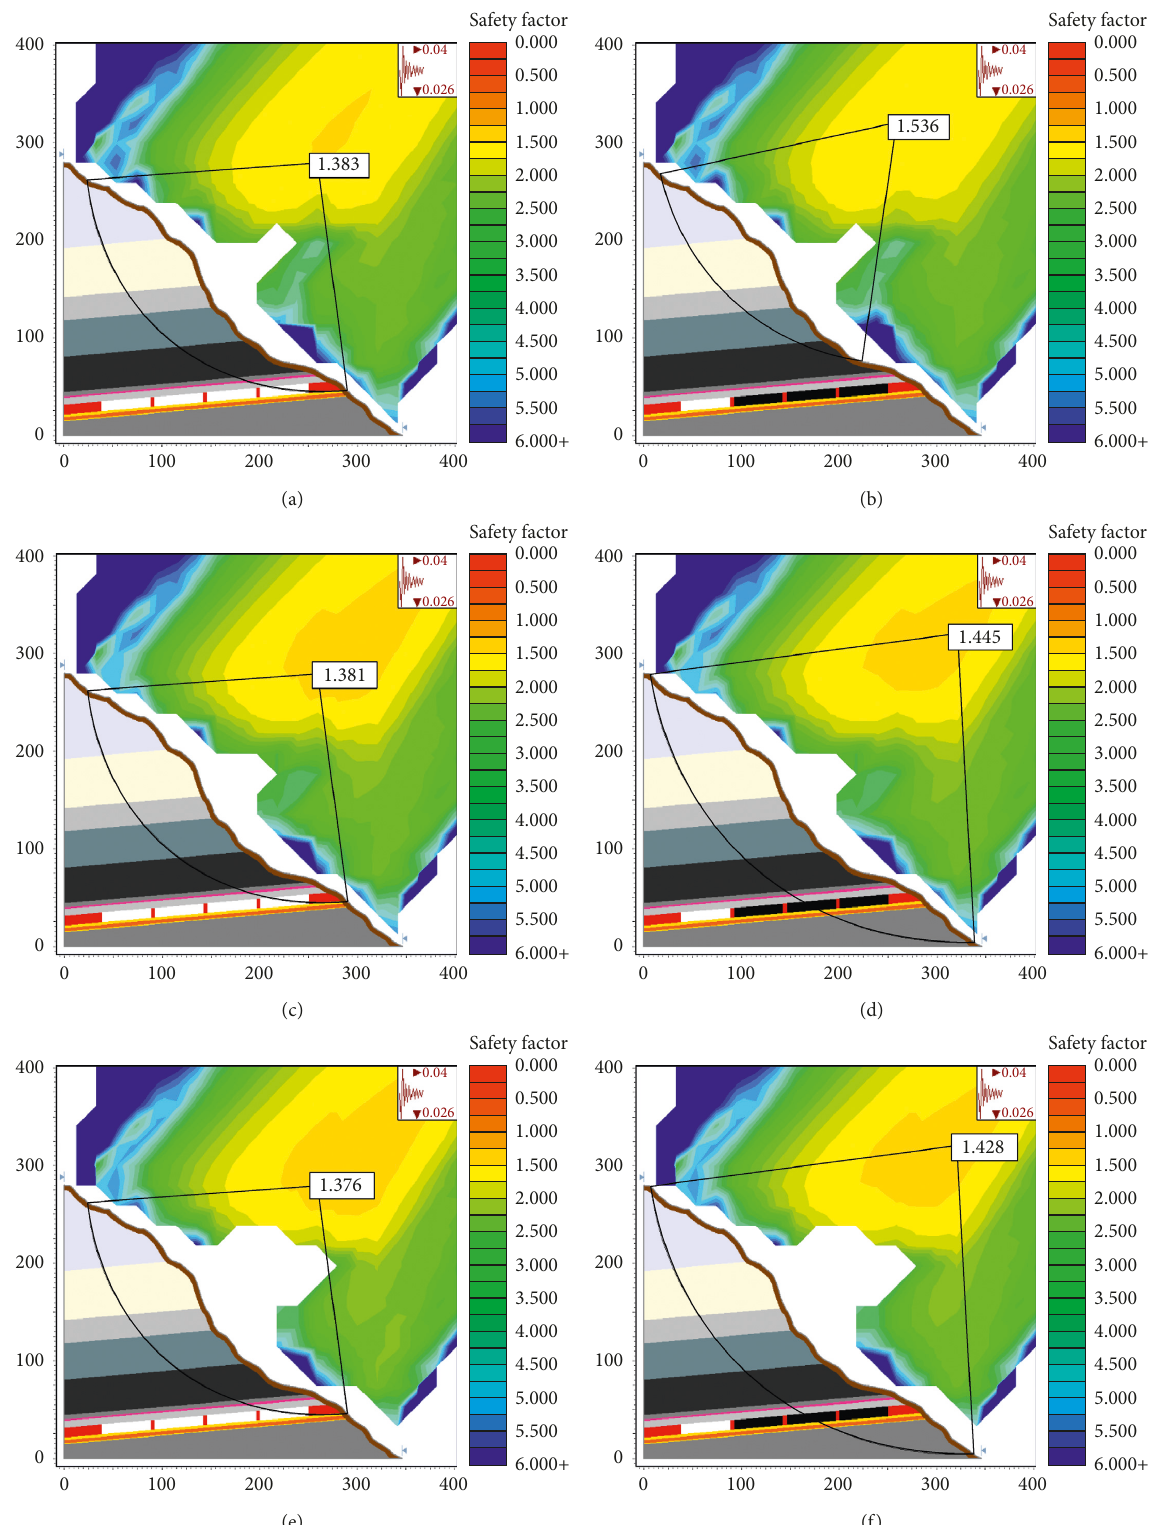
Figure 7: Safety factors of HSRS for seismic conditions: (a) open-stope method using simplified Bishop method; (b) backfill method using simplified Bishop method; (c) open-stope method using Fellenius method; (d) backfill method using Fellenius method; (e) open-stope method using simplified Janbu method; (f) backfill method using simplified Janbu